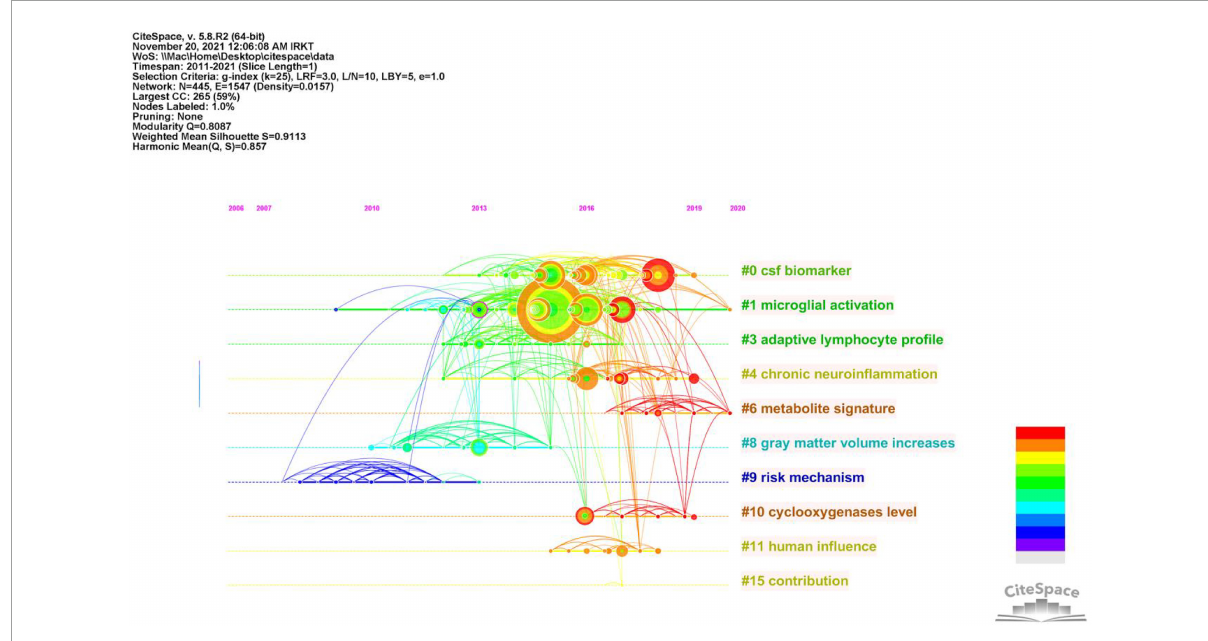
FIGURE7 Timeline of co-citated document clusters from 2011 to 2021. Node size and color represents total number of citations and a single time slice, respectively. Lines of different colors show that the two articles were co-cited in an